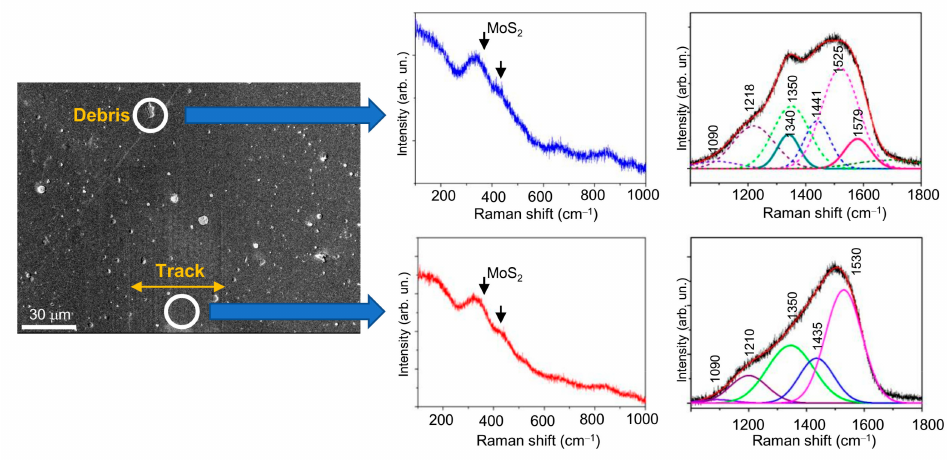
Figure 16. SEM image and Raman spectra for the Mo-S-C-H_5.5 thin-film coating subjected to pin-on-disk test in dry friction conditions at − 100 ◦